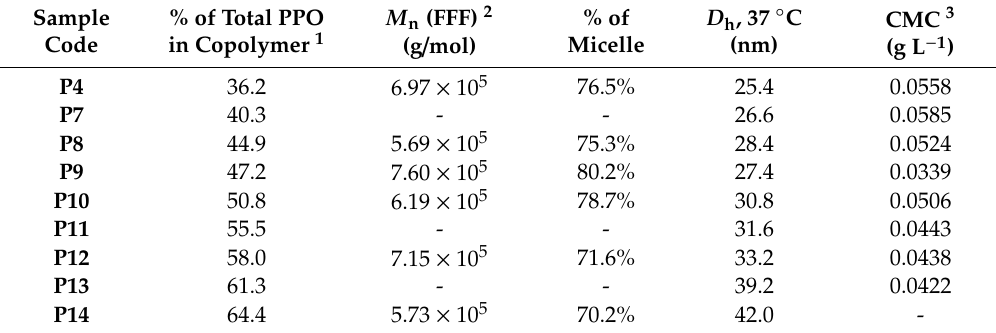
Table 4. Characterization parameters of polymers